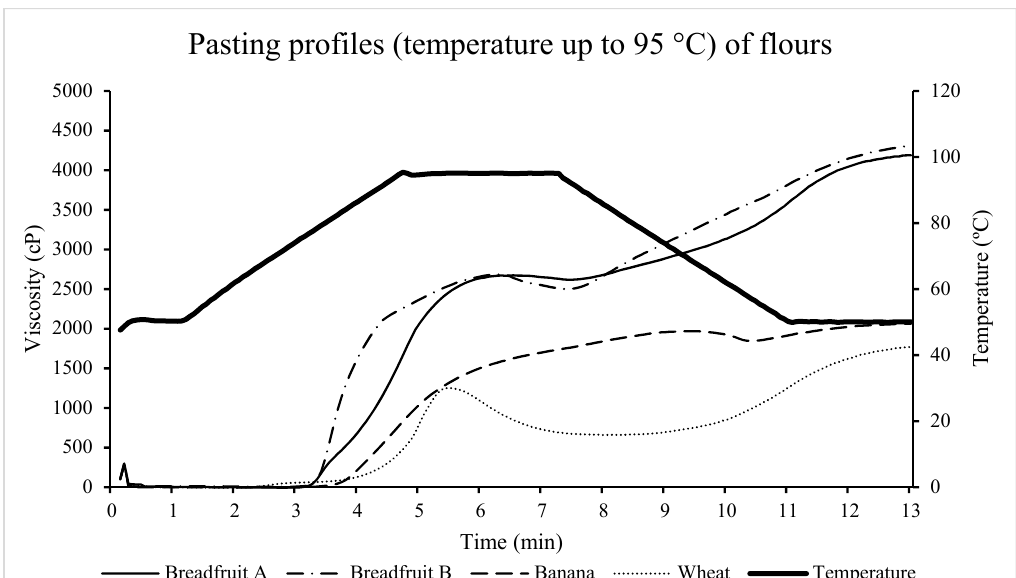
Figure 6. The pasting properties of tropical flours compared with a traditional flour using RVA method #1 (maximum temperature of 95 °C). Treatments were flour types of breadfruit A, breadfruit B, banana, or wheat. Breadfruit flour A was sourced from Natural Foods International (Apia, Western Samoa). Breadfruit flour B was sourced from Jungle Project (Alajuela, Costa Rica). Banana flour was sourced from LiveKuna, Kunachia LLC (Davie, FL, USA). Wheat flour was obtained commercially from Bulk Barn Foods (Aurora, ON, Canada).